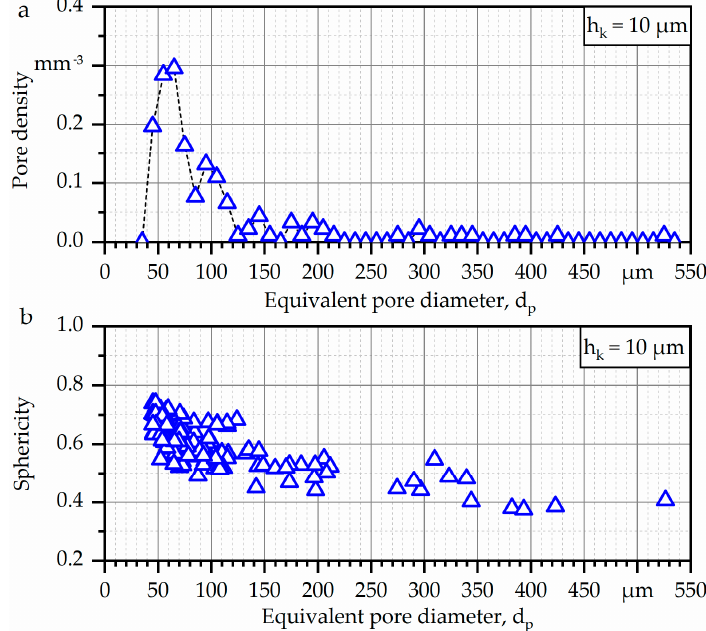
Figure 7. Characteristics of defects being present within the specimen (strut diameter of 2 mm): ( a ) pore density and ( b ) sphericity.